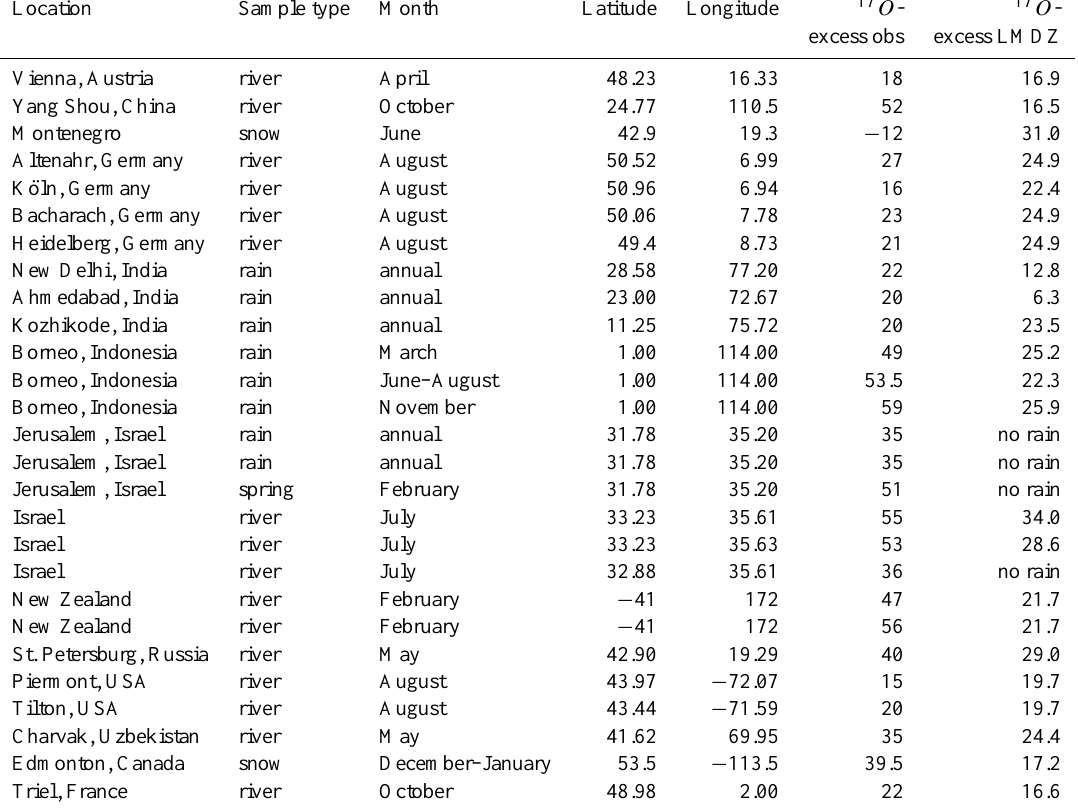
Table 1. Precipitation 17 O -excess simulated by LMDZ, compared to data from (Luz and Barkan, 2010) collected in precipitation or rivers. We did not select lakes, caves or ponds in order to avoid samples affected by re-evaporation after rainfall. Based on land surface isotopic modelling (e.g. Fekete et al., 2006; Risi, 2009) and observations (Kendall and Coplen, 2001), we assume that river water is close to annual- mean precipitation. For rivers, we thus compare with annual mean simulated precipitation composition. When several samples are taken at the same location in the same season, we present